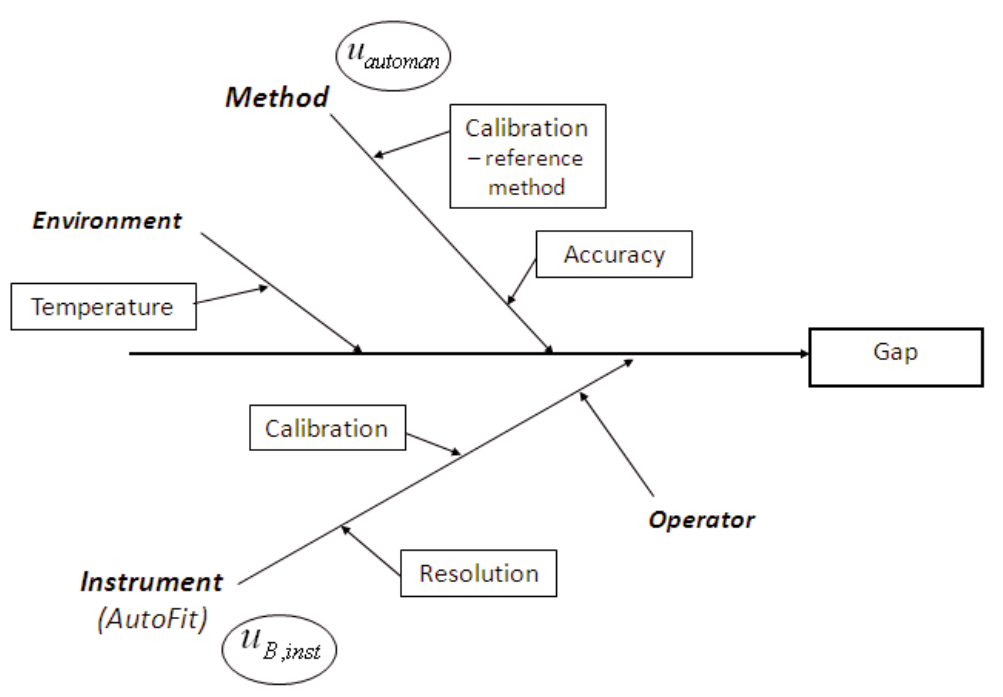
Fig. 2. Measurement uncertainty analysis as an Ishikawa diagram.